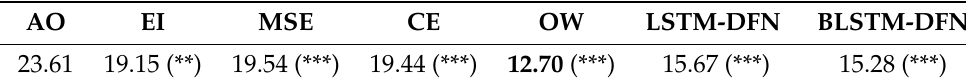
Table 6. Far-field AVSR WER (%) and statistically significance compared with the AO model on the LRS2 dataset. *** denotes p (cid:54) 0.001, ** shows 0.001 < p (cid:54) 0.01